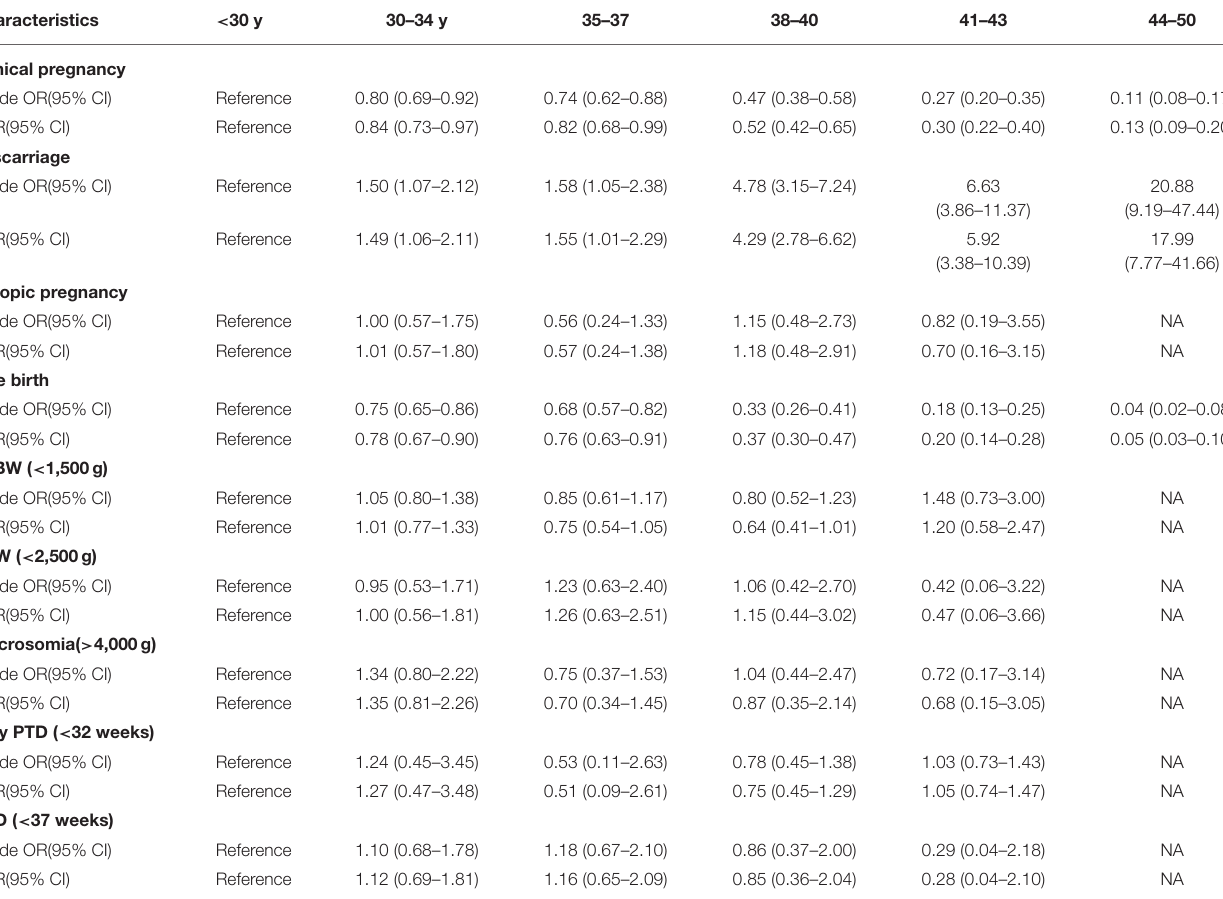
TABLE 4 | Crude and AORs for pregnancy and adverse neonatal outcomes in singleton births.